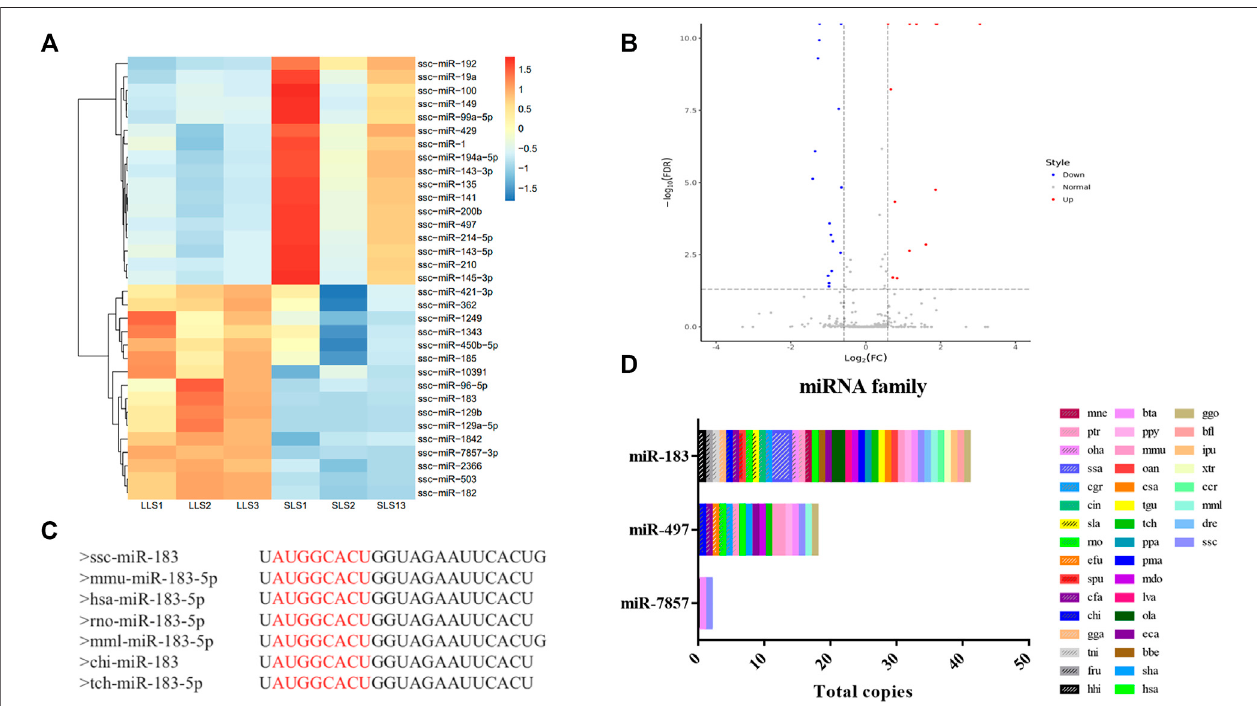
FIGURE 2 | Differential expression and homology analysis of candidate microRNAs. (A,B) A total of 33 differentially expressed miRNAs were screened in the two groups,asshownintheheatmapandvolcanomap,LLSvsSLS16miRNAswereup-regulatedand17miRNAsweredown-regulated. (C) Theconservativesequenceof mir-183 is shown as “ AUGGCACU ” . (D) The family analysis of miR-183, miR-7857-3 and miR-497, of which miR-183 and miR-497 were widely present in multiple